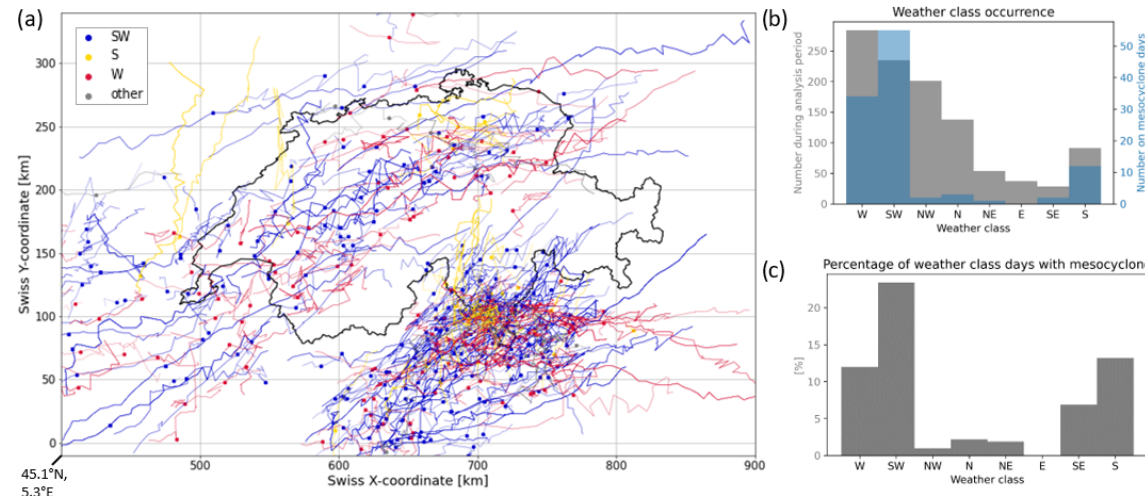
Figure 5. (a) Spatial dependency of the synoptic situation based on prevailing flow at 500hPa. Lines show complete tracks of mesocyclones; dots depict mesocyclone initiation. (b) Histograms of weather class occurrence during entire analysis period and during mesocyclone days. (c) Percentage of days per weather class with mesocyclone